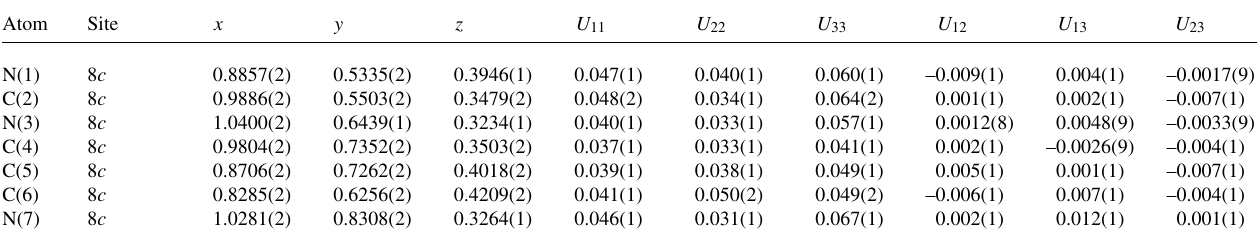
Table 3. Atomic coordinates and displacement parameters (in Å 2 )